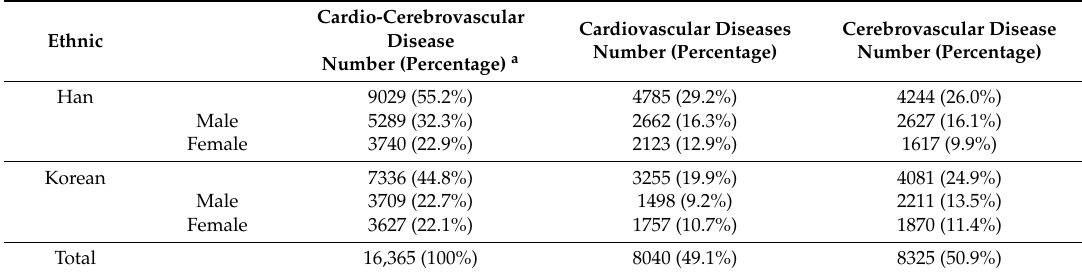
Table 1. Distribution of cardio-cerebrovascular diseases for total population in Yanbian,